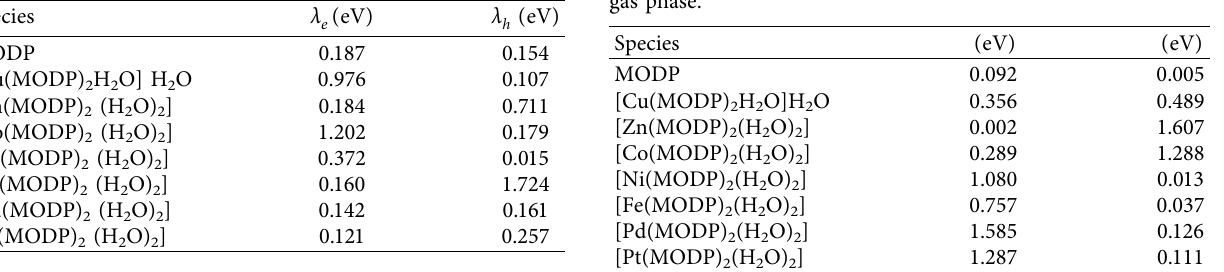
Table 8: Charge transfer integral V molecules computed at PBE0-D3(BJ)/def2-TZVP level of theory in gas phase.